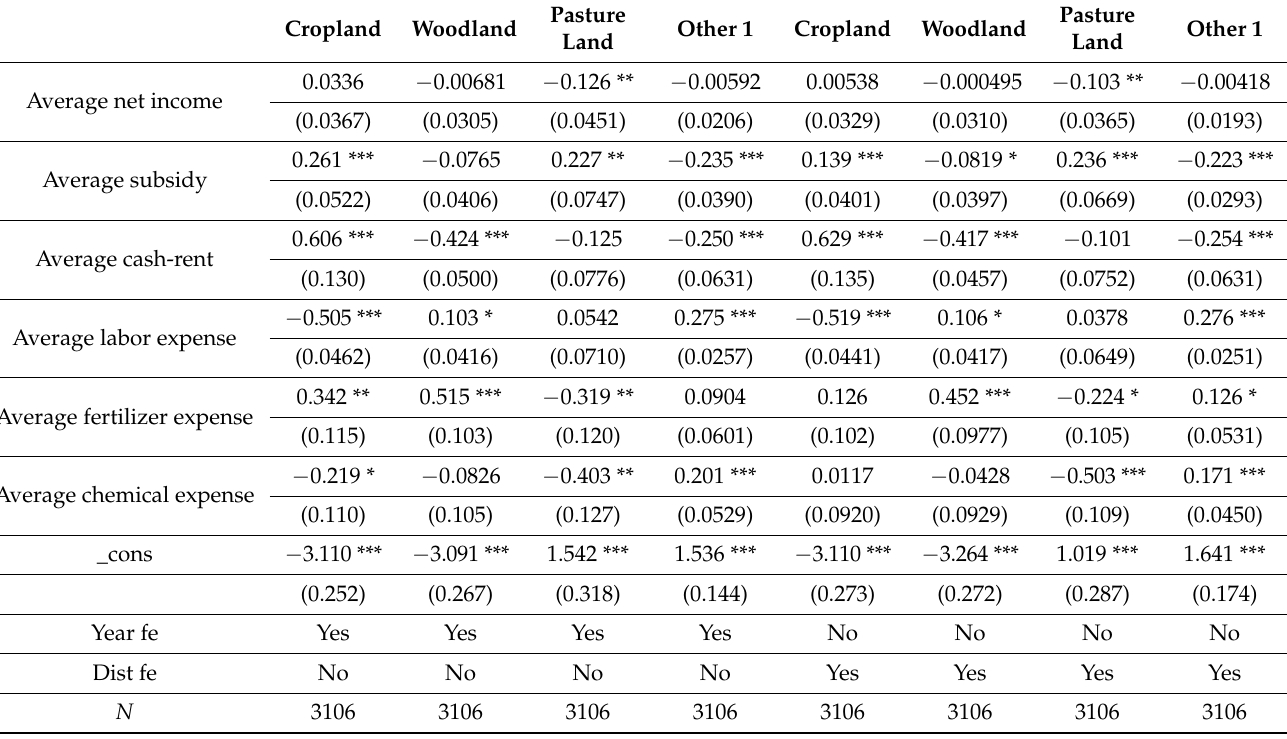
Table 5. Estimated Coefficients on Land-Use of Cropland, Woodland and Pastureland in Multinomial- Fractional-Logit Model with Lagged Variables. Pasture Pasture Cropland